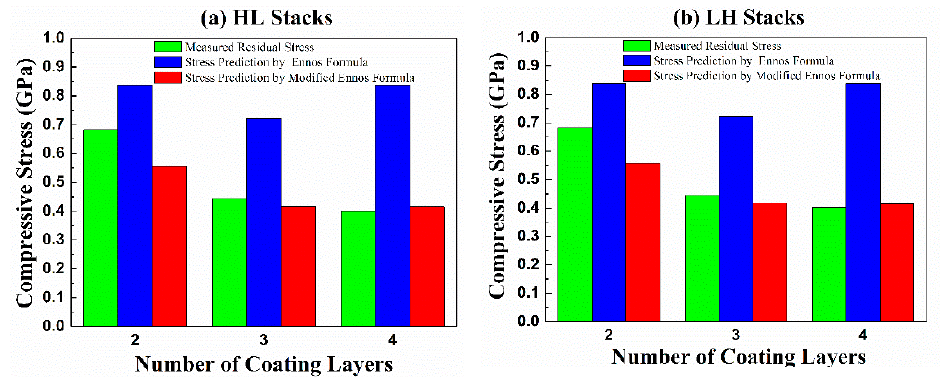
Figure 4. Comparison of the measured stress and the predicted stress from two-layer to four-layer films ( a ) high–low refractive index (HL) stack; ( b ) low–high refractive index (LH) stack.